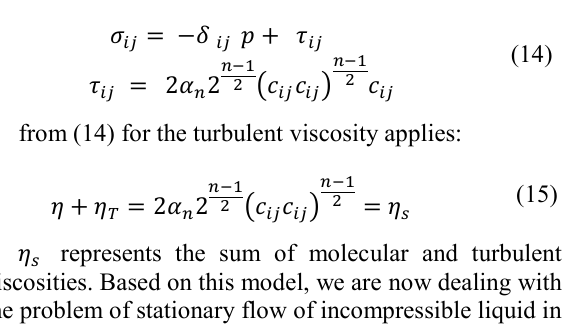
Fig. 1. Velocity profile shape